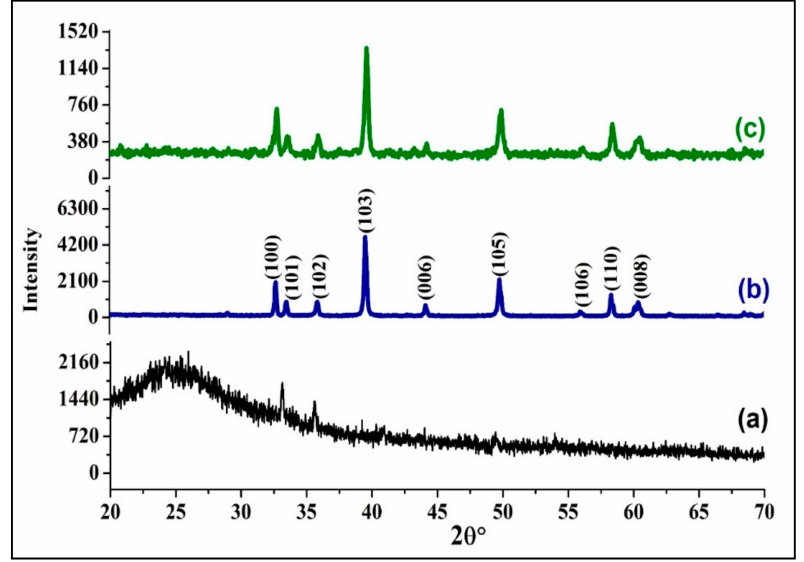
Figure 2. The X-ray di ff raction (XRD) spectra of: ( a ) PPy, ( b ) MoS 2 and ( c ) PPy / MoS 2